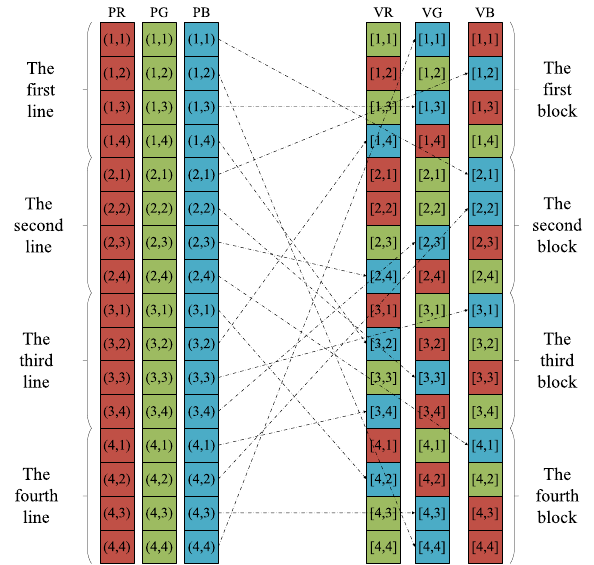
Fig. 6 Illustration of the permutation process matrix E , E ( i , j ) ∈ [0, 2], S ( i , j ) ∈ (cid:17) 1, L 2